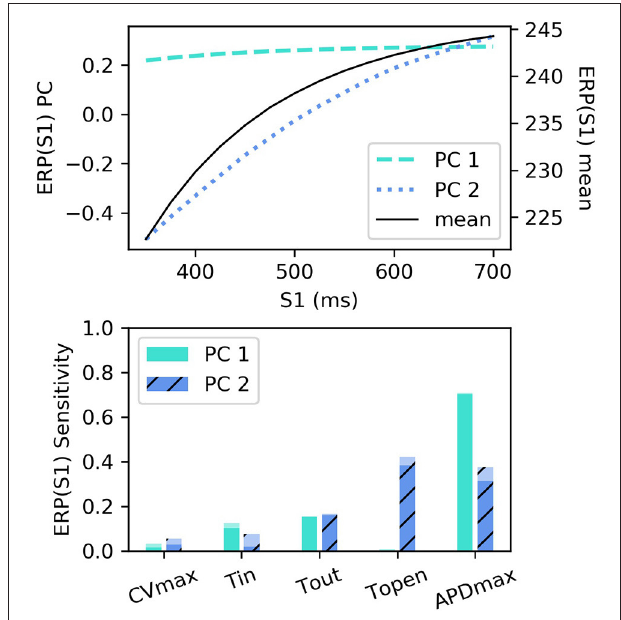
FIGURE 6 | ERP(S1) restitution curves, showing (top) principal components and mean, and (bottom) first-order and total-effect sensitivity indices for the coordinates of the principal